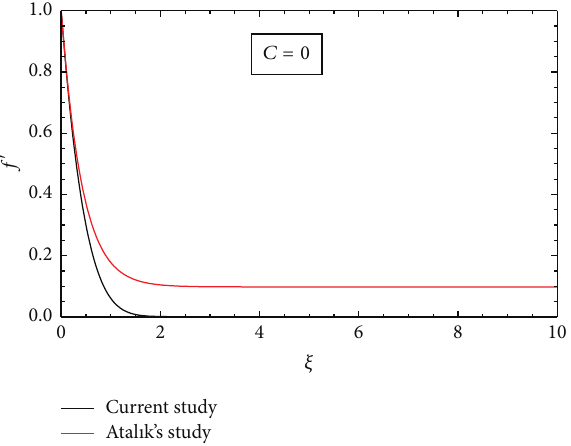
Figure 3: Comparison of similarity functions of velocity for 𝐶 = 0 of current study and Atalık